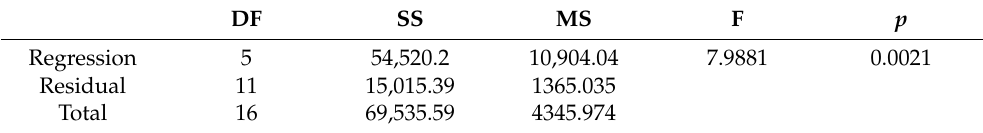
Table 5. Analysis of variance for hydrogen production based on food waste carbohydrate added